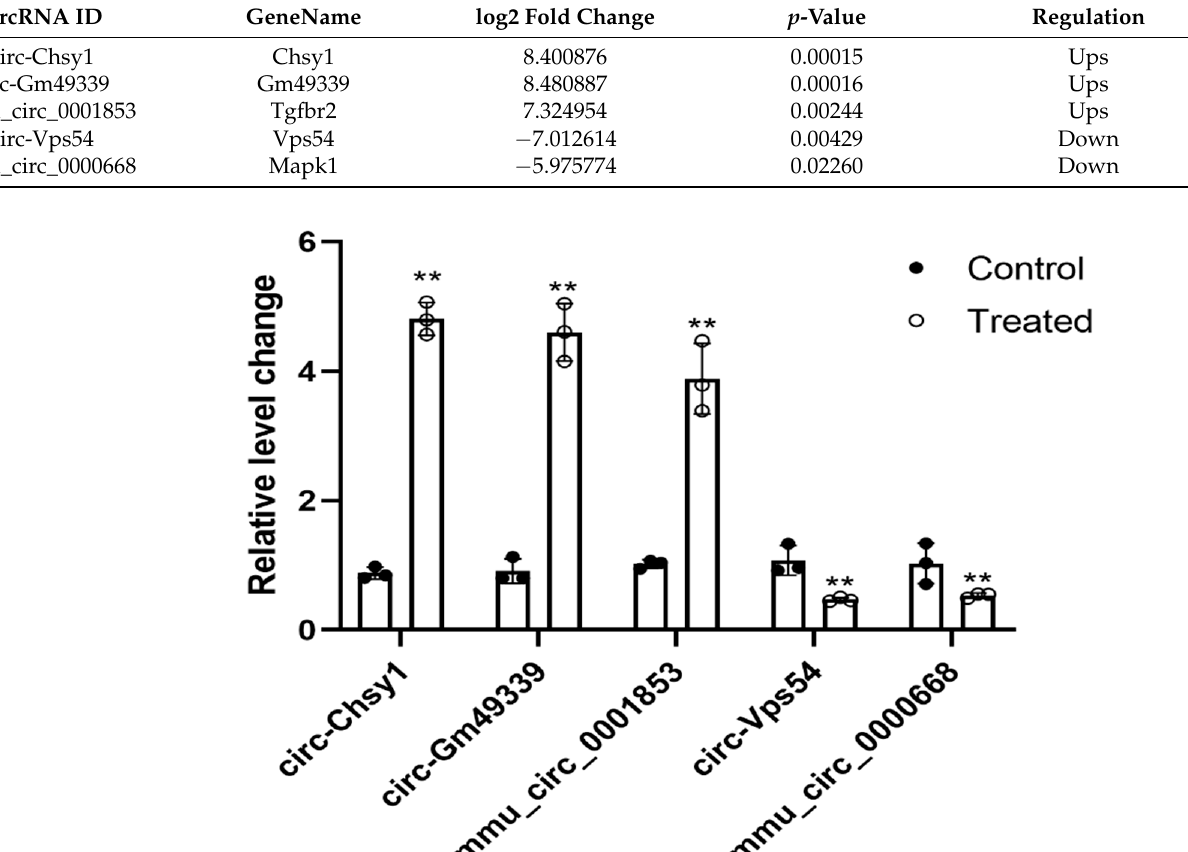
Table 2. The sequencing results of differential circular RNAs.